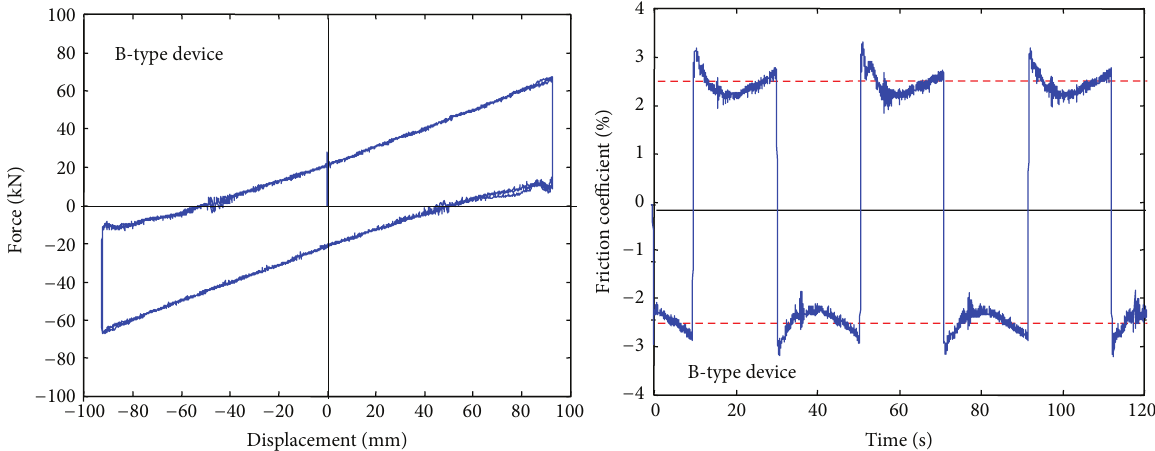
Figure 8: Response cycles and portion of the friction coefficient time-history obtained from a dynamic test carried out on one B-type isolator, = ±91 mm, V = 10 mm/s, and 𝑉 = 1100 kN. with 𝑑 c , max d